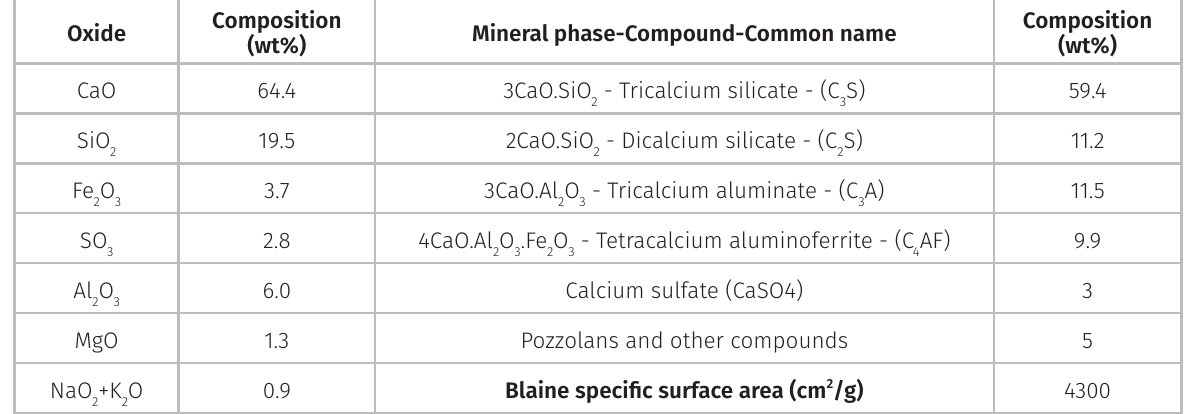
Table I. Chemical and mineral composition, and the Blaine specific surface area of the HE cement. Composition Oxide